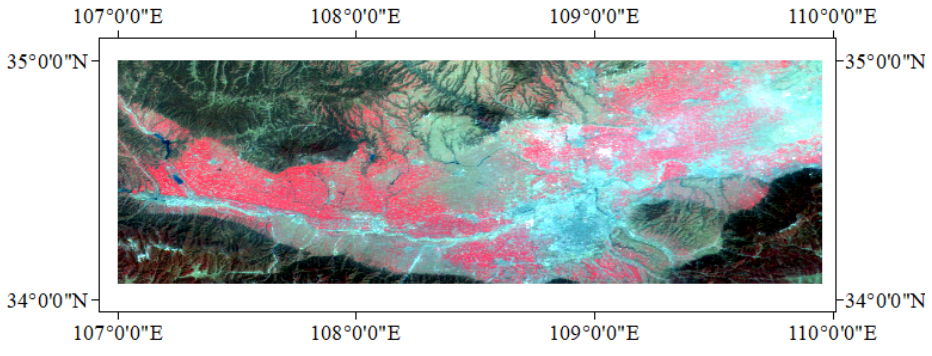
Figure 2. Pre-processed image (15 March